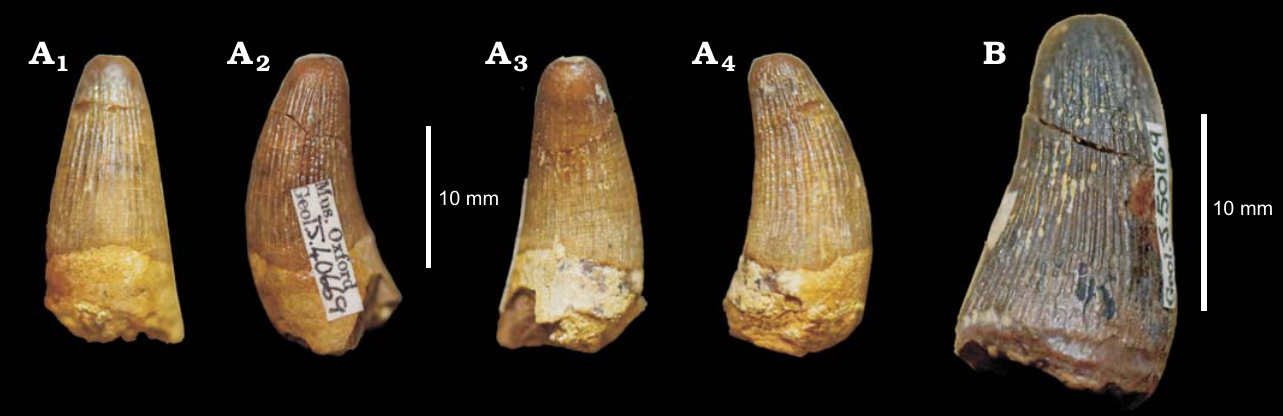
Fig. 9. Teeth of Machimosaurini indet. from Corallian. A . OUMNH J.40669, unkown locality, “Corallian beds”, Oxfordian, in labial (A 1 ), axial (A 2 , A 4 ), and lingual (A 3 ) views. B . OUMNH J.50169, from Headington (Oxfordshire), middle Oxfordian, in lingual/axial oblique